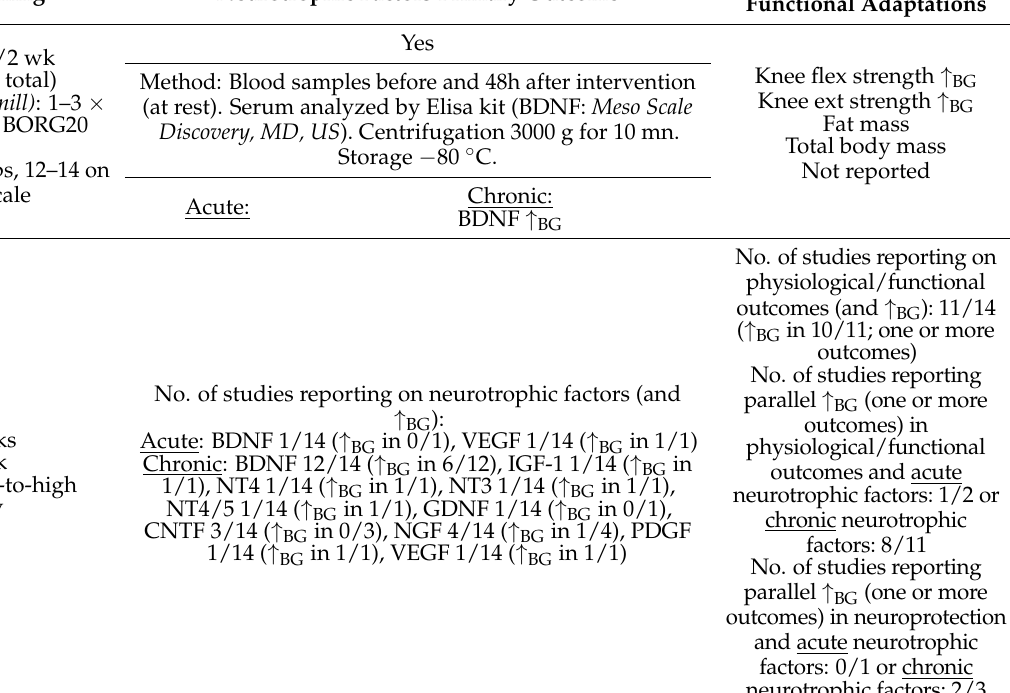
Neurotrophic Factors Primary Outcome